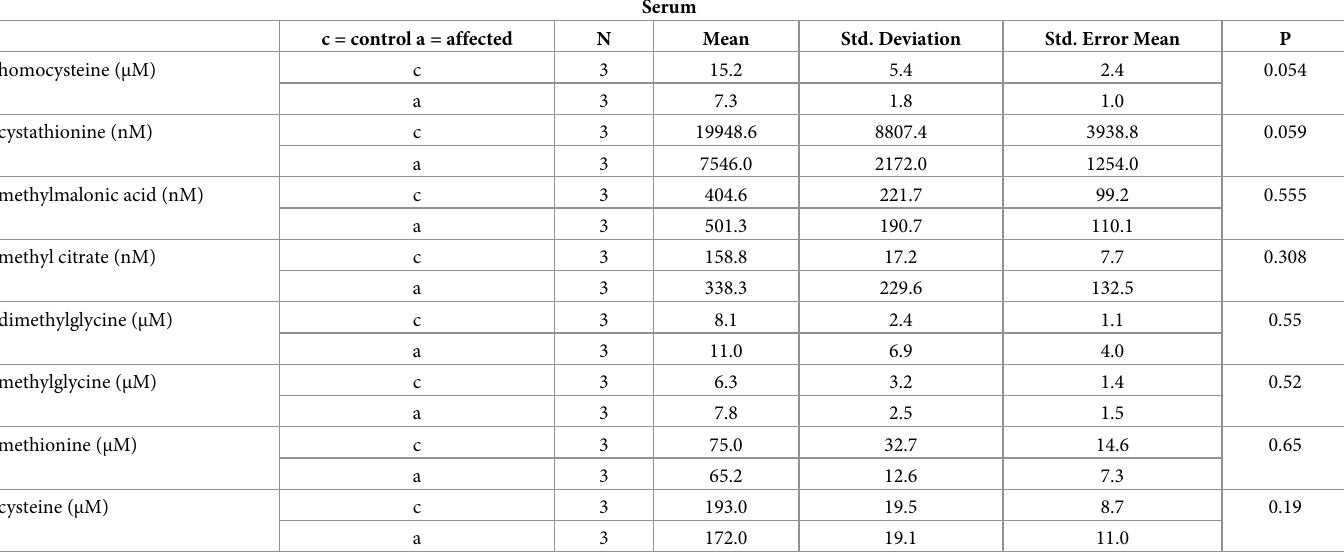
Table 1. Analyses of Vitamin B12 metabolites in serum.